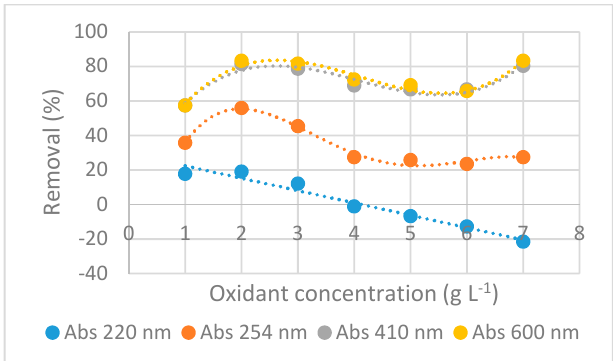
Figure 4. Effect of hydrogen peroxide oxidation on the removal of absorbances.